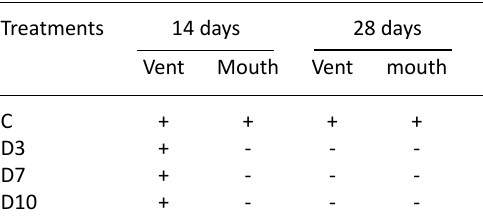
Table 4. Effect of microsafe spraying on the average live body weight and body weight gain (gm) of broiler chickens ± SE Age (days) Treatments